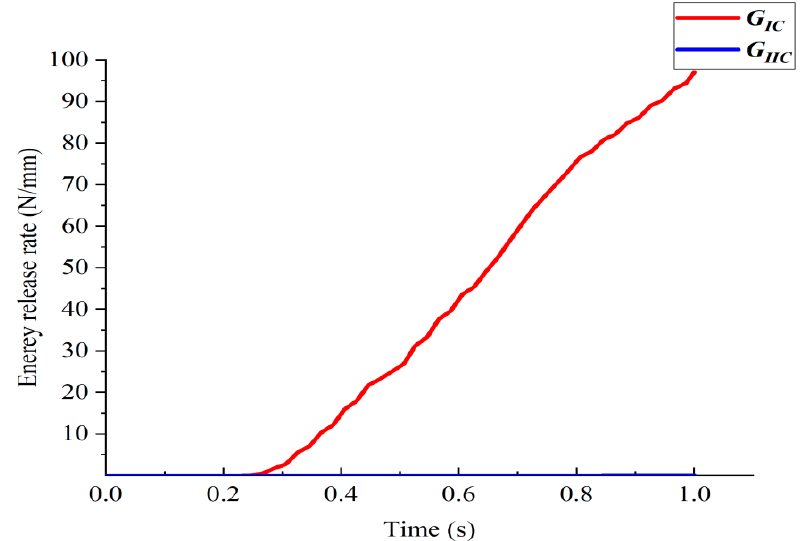
Figure 5. Energy release rate versus time for model I delamination failure.